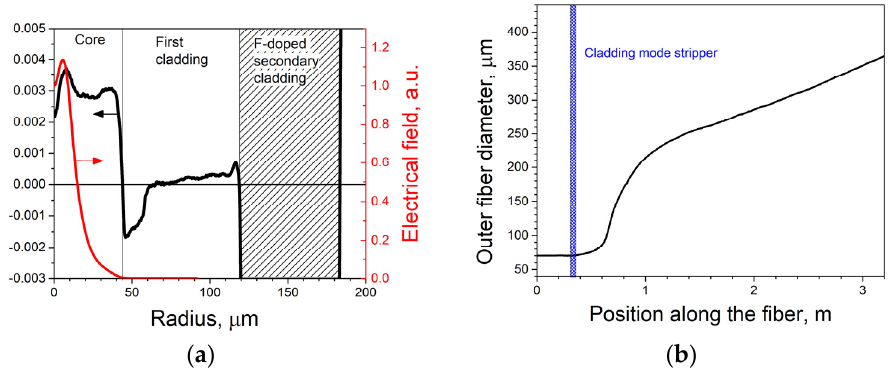
Figure 1 . ( a ): refractive index profile (black line) and calculated (using actual refractive index profile) electrical field distribution of the fundamental mode (red line) in the thick end of the fabricated tapered Er-doped fiber; ( b ): dependence of the tapered Er-doped fiber diameter on its length.